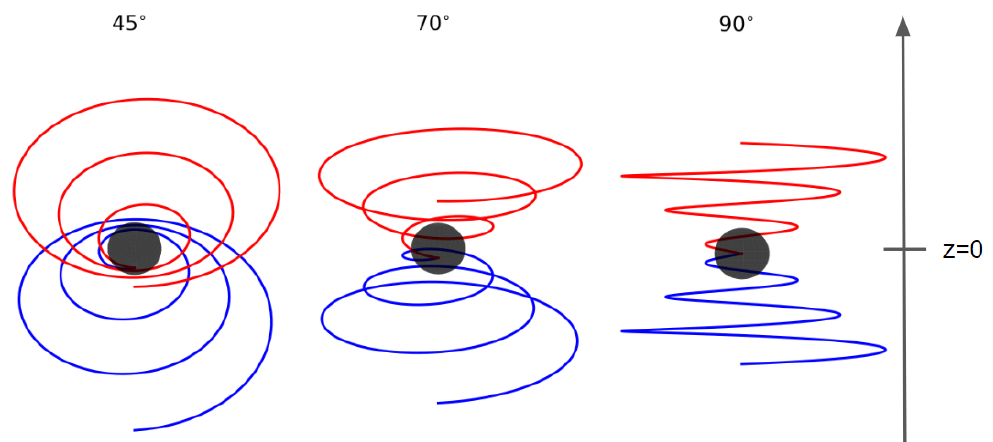
Figure 2. Schematic magnetic configuration of a jet model. Along the black hole rotational axis, the region above (or below) the equatorial plane is referred to as z > 0 (or z < 0). Cases for different viewing angles with respect to the rotational axis are shown (from left to right: 45 ◦ , 70 ◦ , and 90 ◦